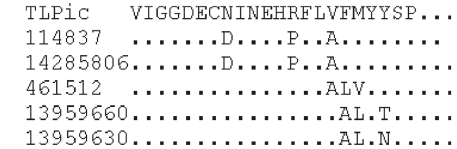
Figure 6: Analysis of sequential homology. Sequential homology for the thrombin-like protein TLBpic from Bothrops pictus venom is shown (114837 (batroxobin, Itoh et al. [22]); 14285806 (bothrombin, Nishida et al. [23]); 461512 (Ancrod, Kisiel et al. [24]); 13959660 (pallabin, Fan et al. [25]); 13959630 (calobin, Hahn et al.